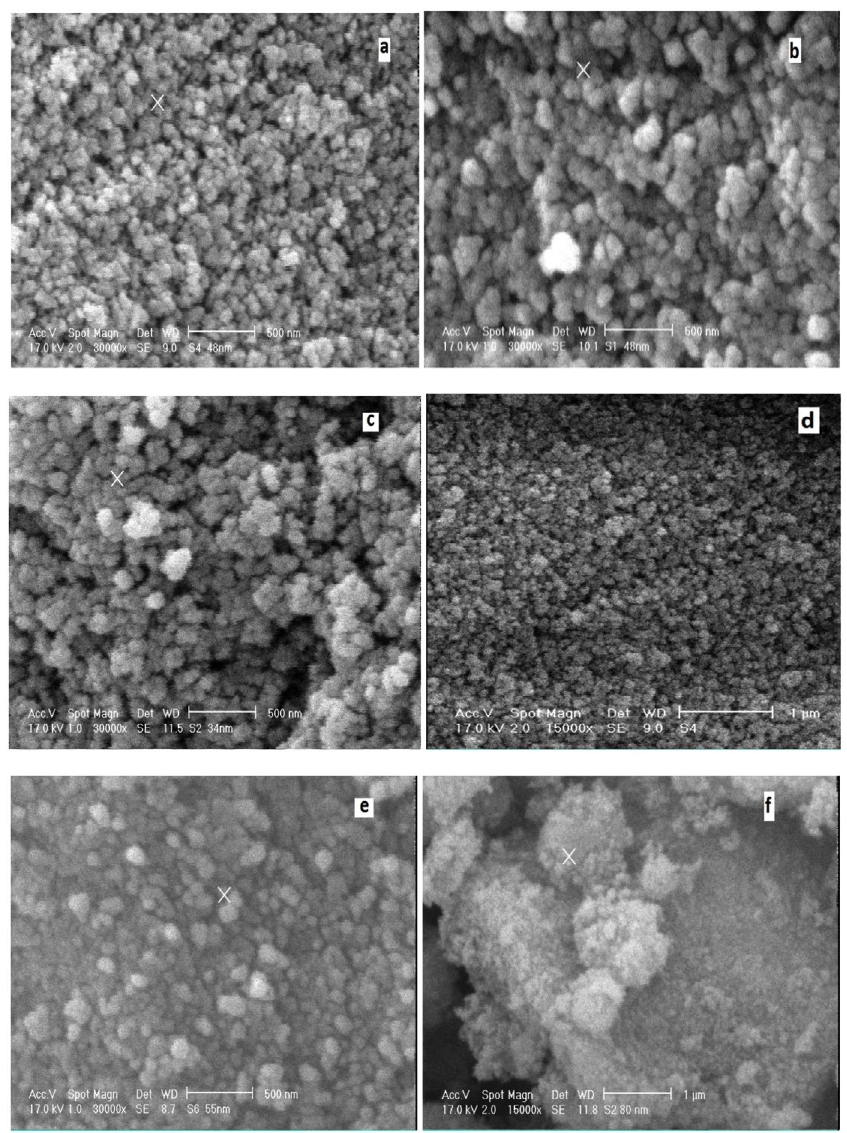
Fig. 3. SEM images of γ- Fe O @HAp decorated with (a) Mn(II), (b) Fe(II), (c) Co(II), (d) Ni(II), (e) 2 3 Cu(II) and (f) Zn(II) (for a, b, c and e scale bar: 500 nm, for d and f scale bar: 1